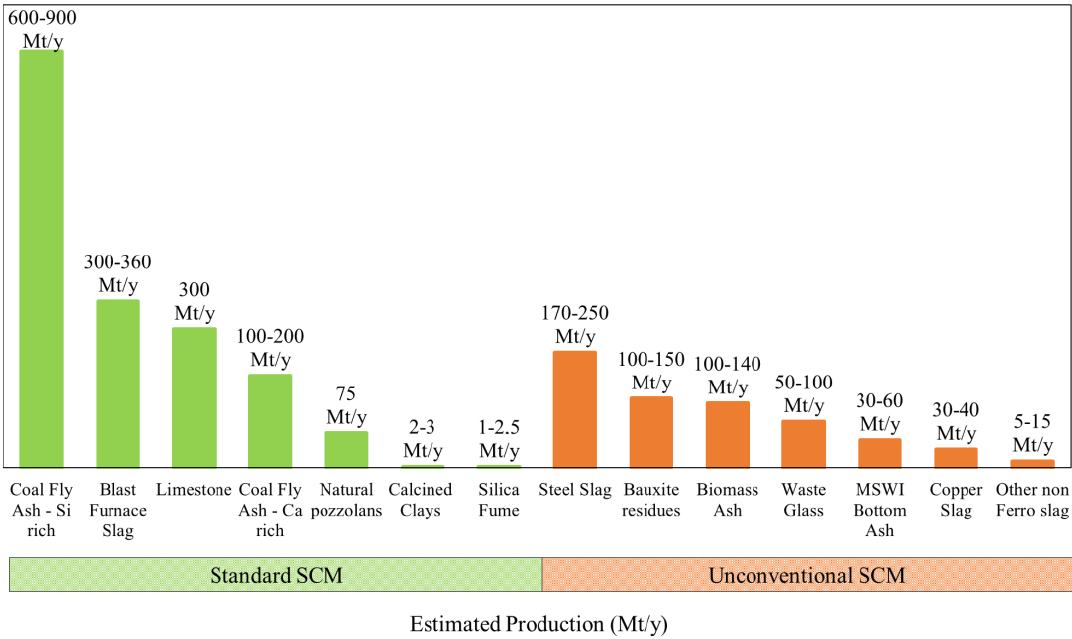
Figure 11. Worldwide availability of standard and unconventional SCM (Mt/y) that can be incorpo- rated in cement-based materials (data source [110]).